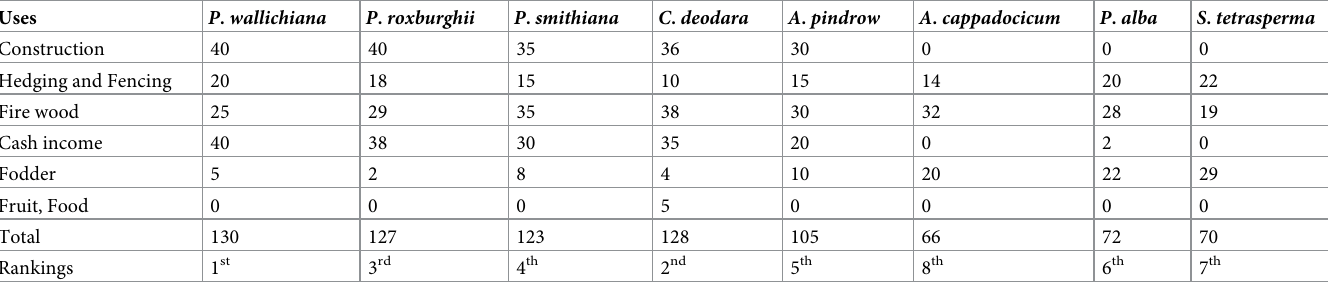
Table 11. Direct matrix ranking (DMR) of tree species with different uses other than medicinal value from Dawarian and Rati Gali, AJK, Pakistan.